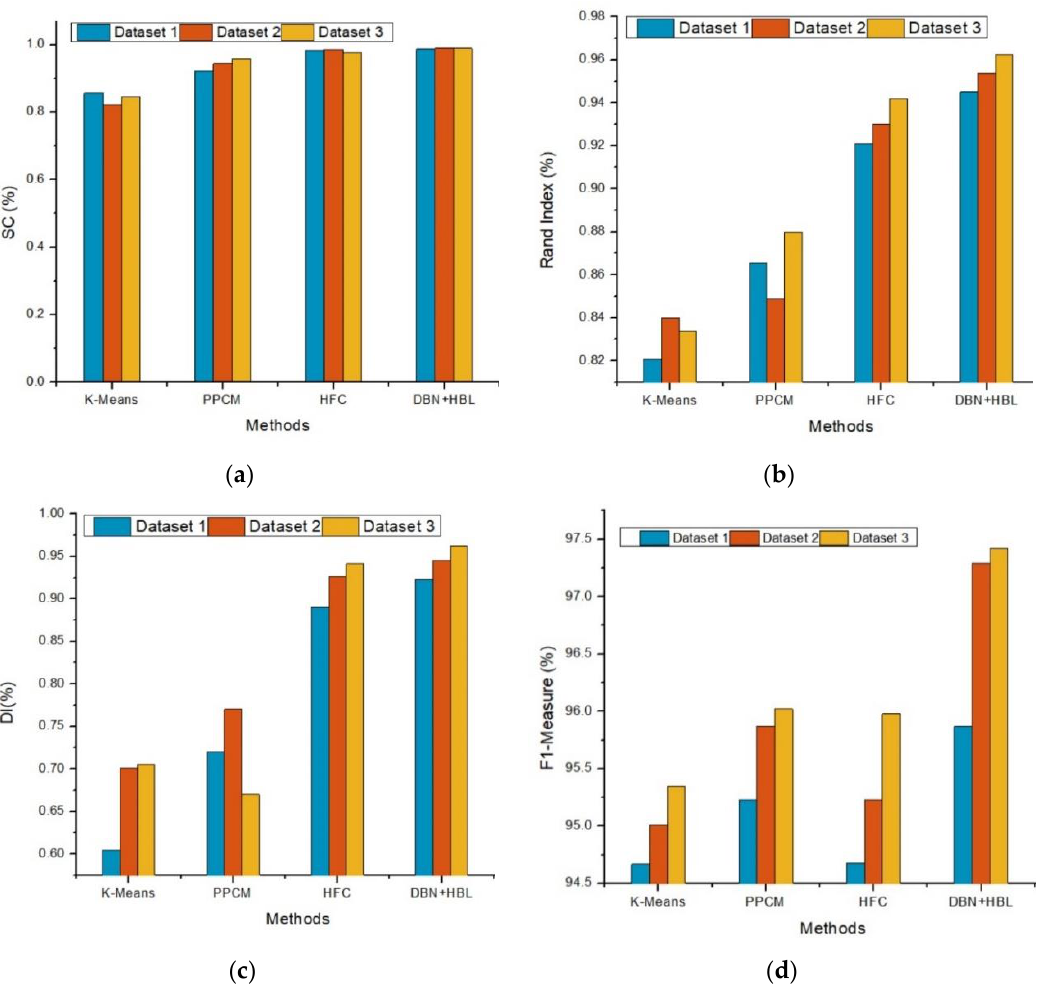
Figure 5. ( a ) SC analysis, ( b ) RI analysis, ( c ) DI analysis, and ( d ) F1-Measure analysis of DBN-HBL.